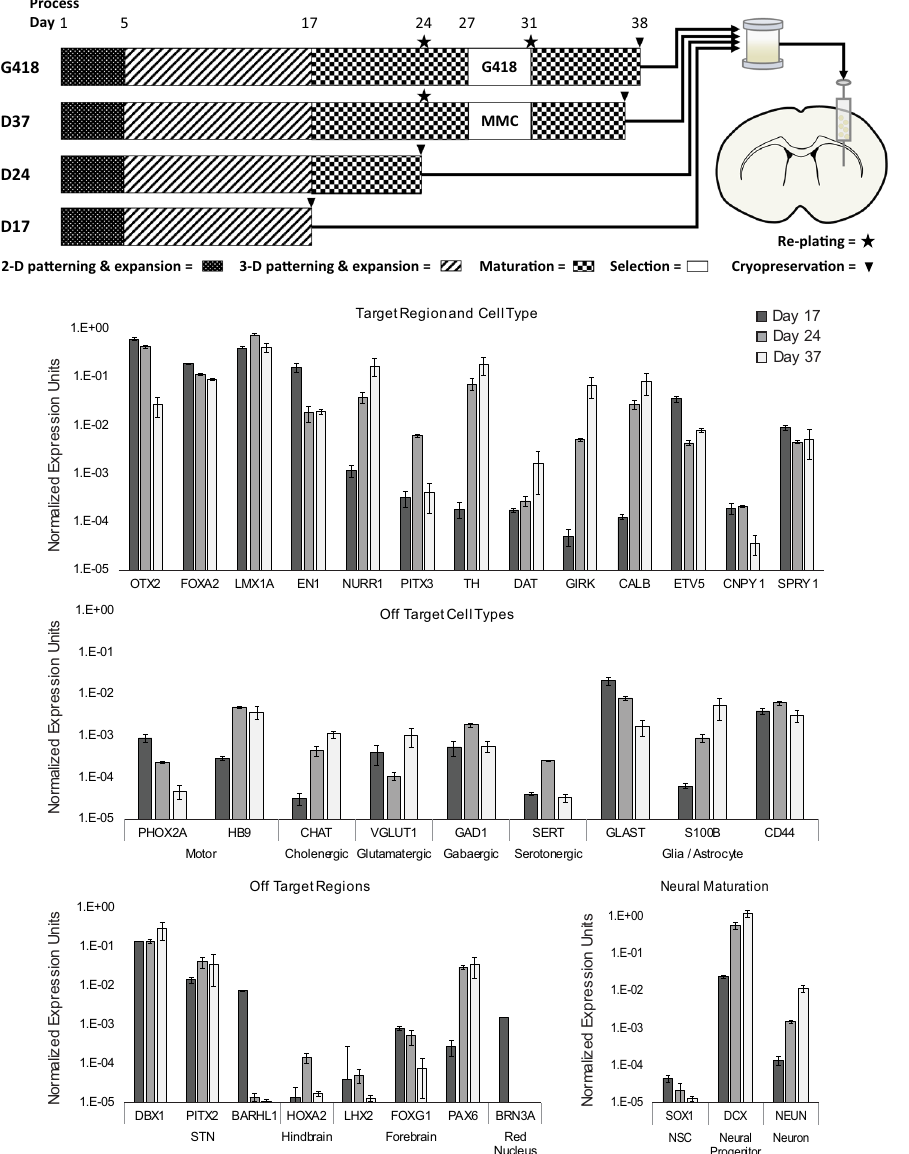
Fig. 1 Differentiation and gene expression in vitro. A Schematic representation of differentiation and transplantation. MMC = mitomycin c. B qPCR comparing mRNA expression at iPSC-mDA differentiation Days 17, 24, and 37 of target and off-target regional, cell type, and neural maturation markers. Three biological replicates were analyzed in technical triplicate for each process time point. Mean Ct values are expressed as relative to glyceraldehyde ‐ 3 ‐ phosphate dehydrogenase (GAPDH) ( Δ Ct). Error bars are SEM. Signi fi cance indicated in Supplementary Table